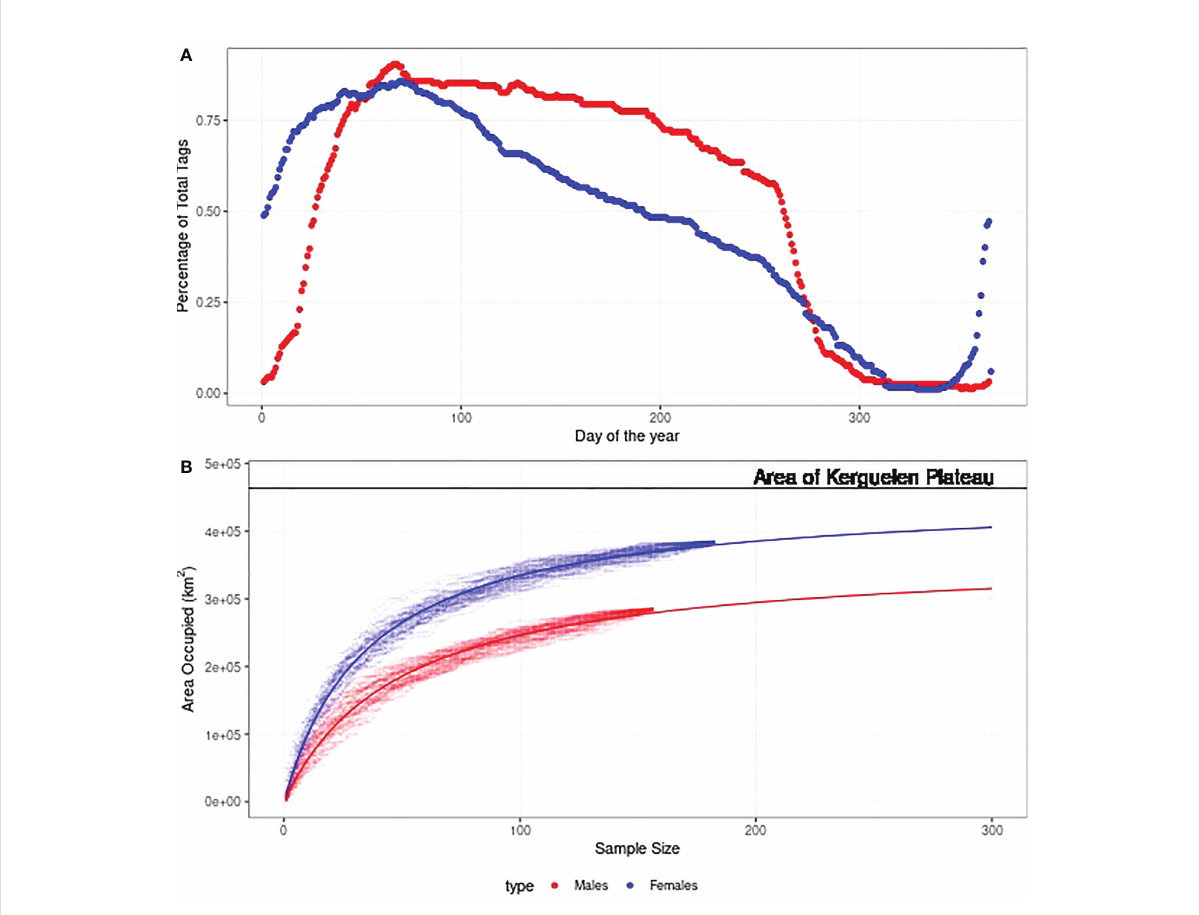
FIGURE 2 Basic diagnostics of the 338 CTD SLDR tags deployed on the sample of southern elephant seals at Iles Kerguelen. (A) Tag performance in terms of transmission duration, showing the percentage of the total number of tags deployed transmitting each day of the year. (B) Saturation curves to demonstrate how representative the sample of 182 males and 156 female seals were of the overall, unsampled population. The dots represent the total area occupied by increasing samples of seals randomized 50 times. A power curve was fi tted to these data using a Michaelis- Menten formulation to demonstrate the theoretical asymptotic area. Also shown as a horizontal black line the total area of the Kerguelen Plateau, 462,975 km 2 (de fi ned as shallower than -2000m and excluding